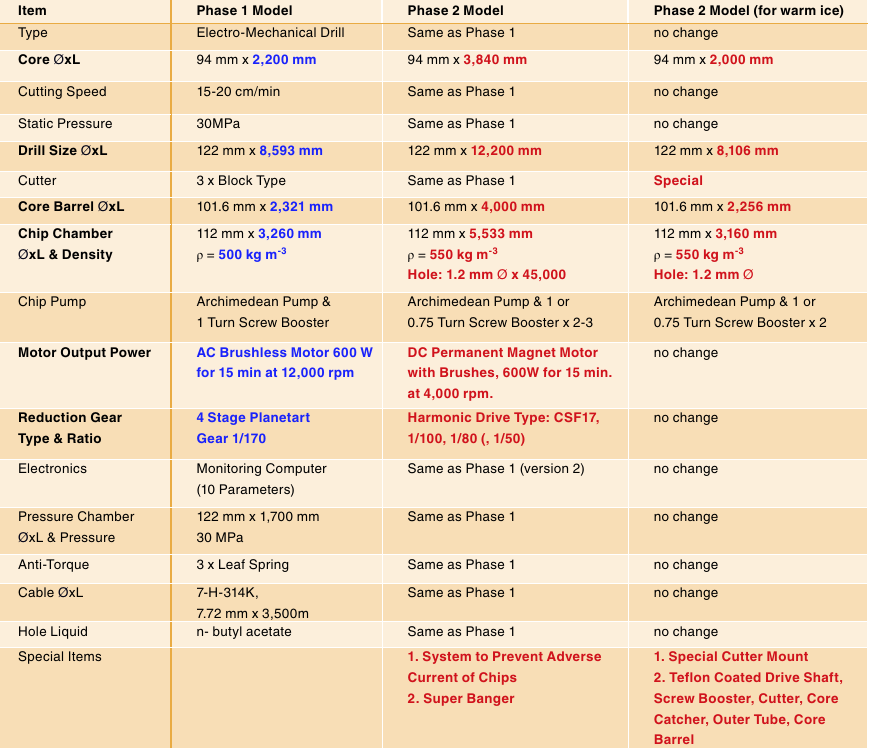
Table 1: Specs of the JARE phase 1 drill and the improved model used for normal and “warm” ice during Phase 2.